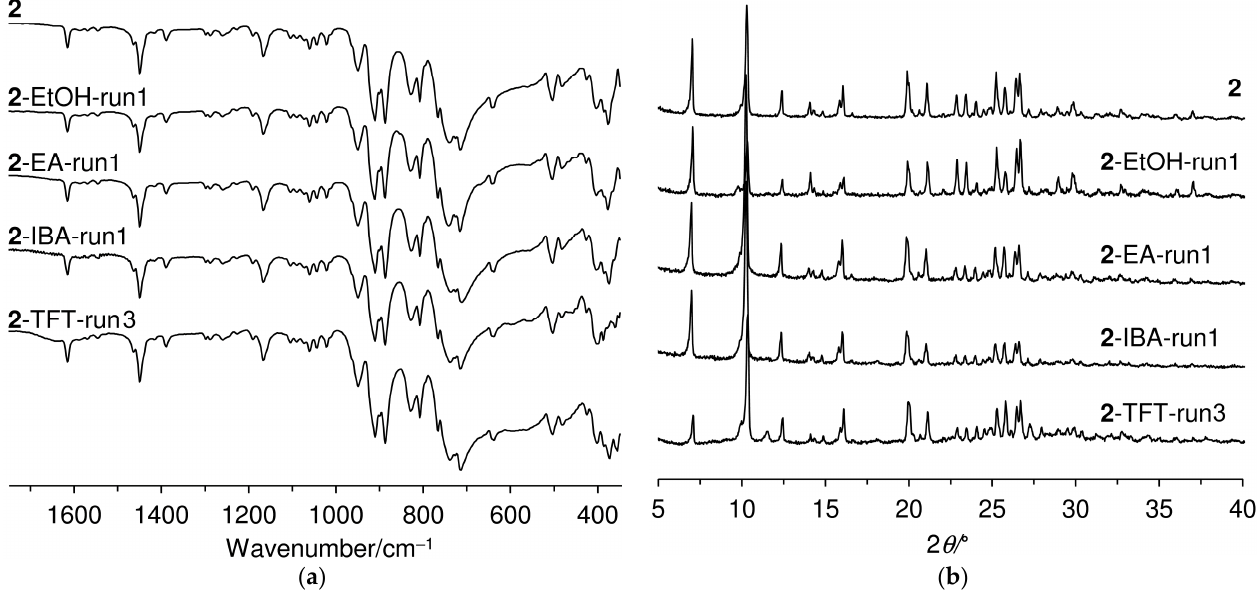
Figure 10. ( a ) ATR FT ‐ IR spectra and ( b ) PXRD patterns of 2 and the (undissolved) solids separated from the catalytic systems 2 /Cy8/TBHP/solvent.